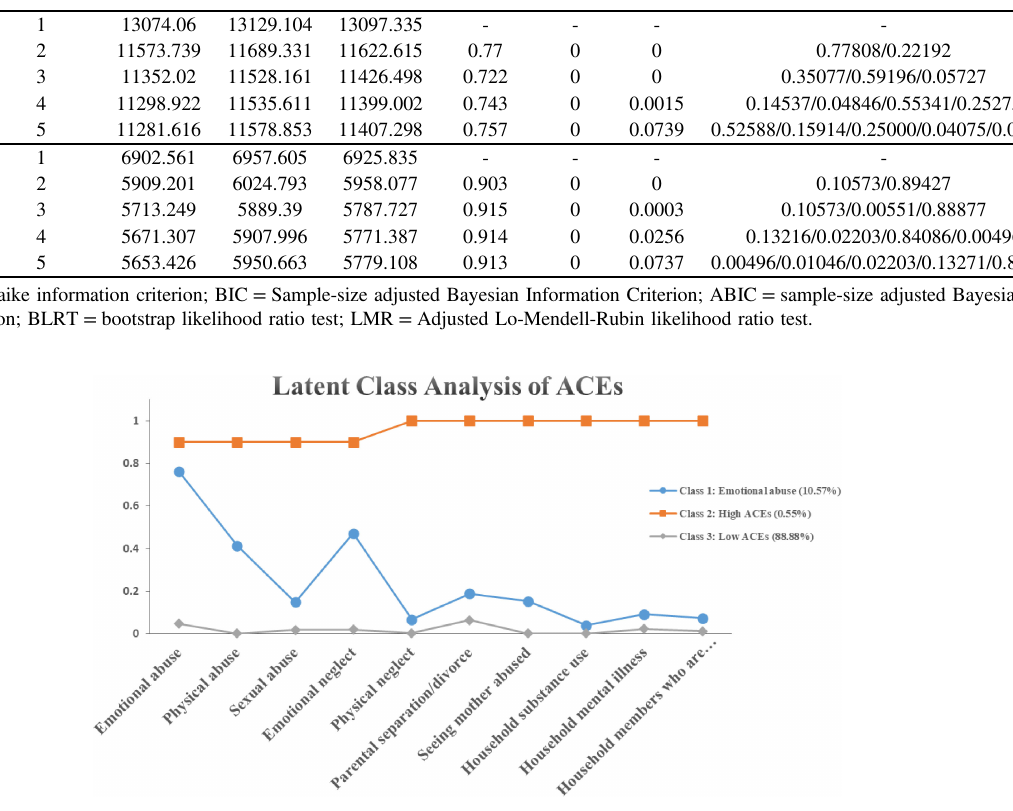
Table 2 LCA fi t indices of childhood experiences among Chinese undergraduate Childhood experience Group